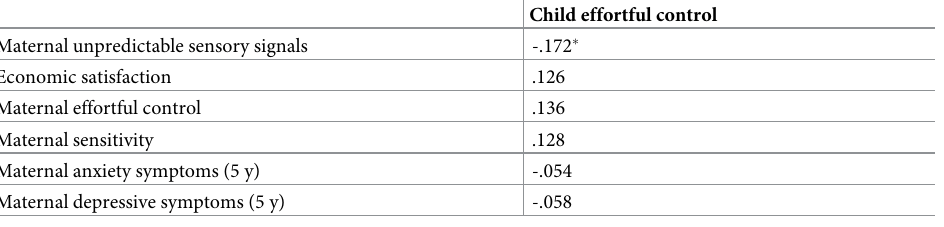
Table 1. Pearson correlations between possible confounding factors, maternal unpredictable sensory signals, and child effortful